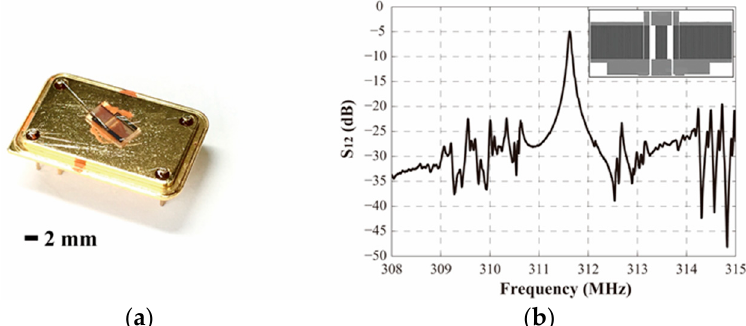
Figure 12. Fabricated SAW resonator: ( a ) photograph; ( b ) measured frequency response.